Question: Which visualization type does this figure use?
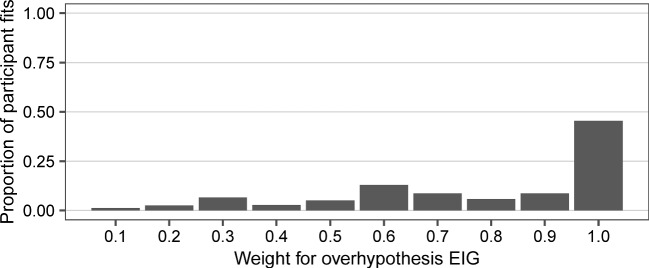
Answer: histogram